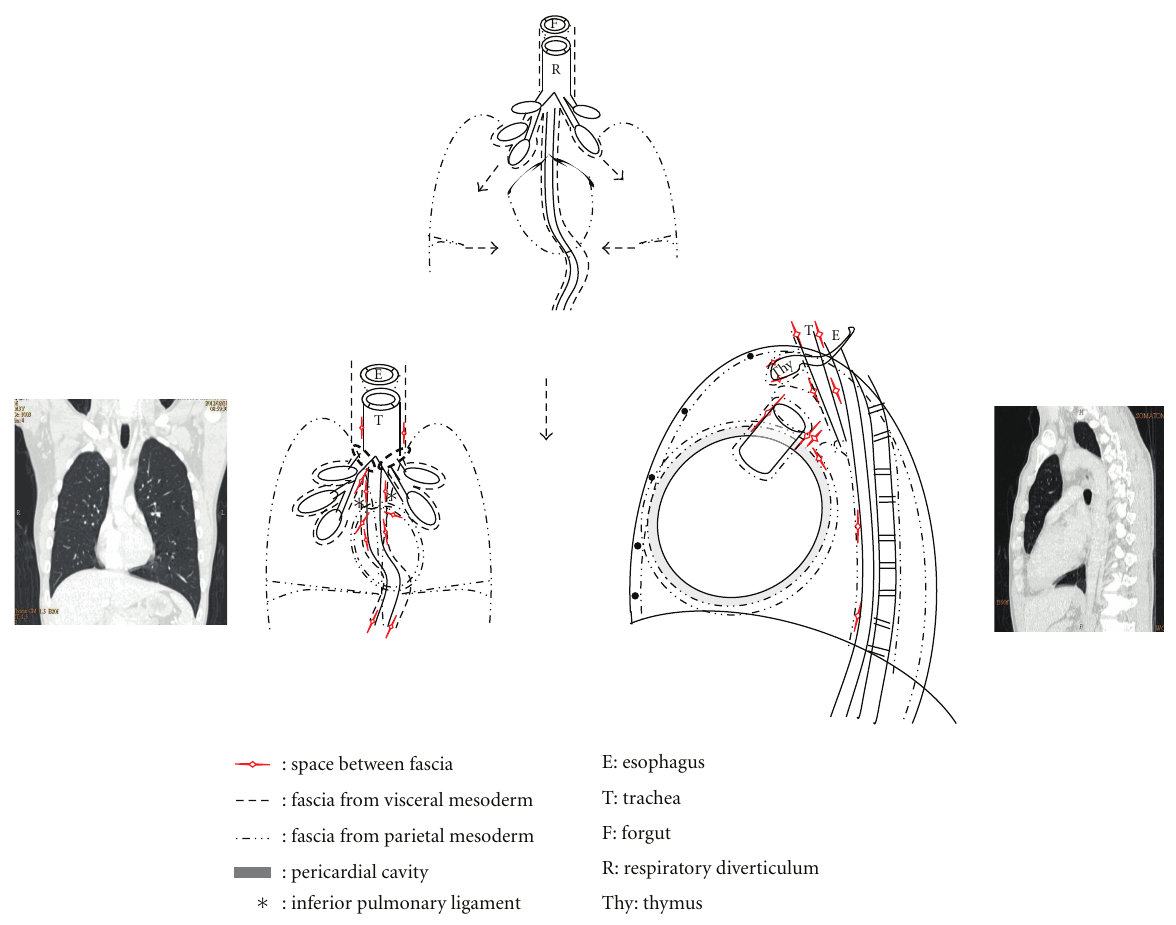
Figure 6: Diagram shows that the formation of the continuity of the fascial planes connects cervical soft tissue with the mediastinum to the retroperitoneum. The space between fascia permits aberrant air arising in any of these areas to spread